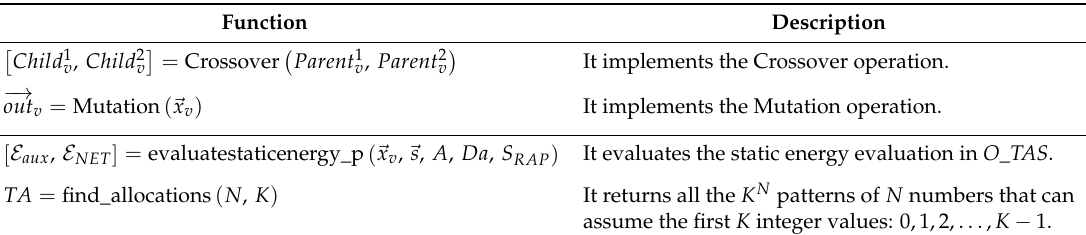
Table 3. Auxiliary functions implemented by VirtFogSim . Function